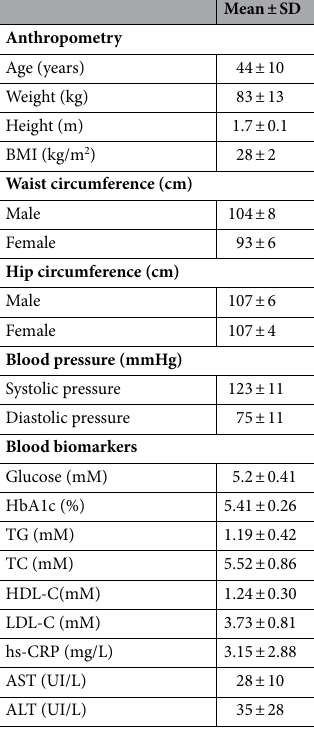
Table 1. Subjects’ anthropometric and metabolic characteristics at baseline (n = 15). Data are expressed as mean ± SD. BMI, body mass index; HbA1c, glycated hemoglobin; TG, triglyceride; TC, total cholesterol, HDL- C, high density lipoprotein cholesterol, LDL-C, low density lipoprotein cholesterol; hs-CRP, high sensitivity C reactive protein; AST, Aspartate Aminotransferase; ALT, Alanine Aminotransferase.